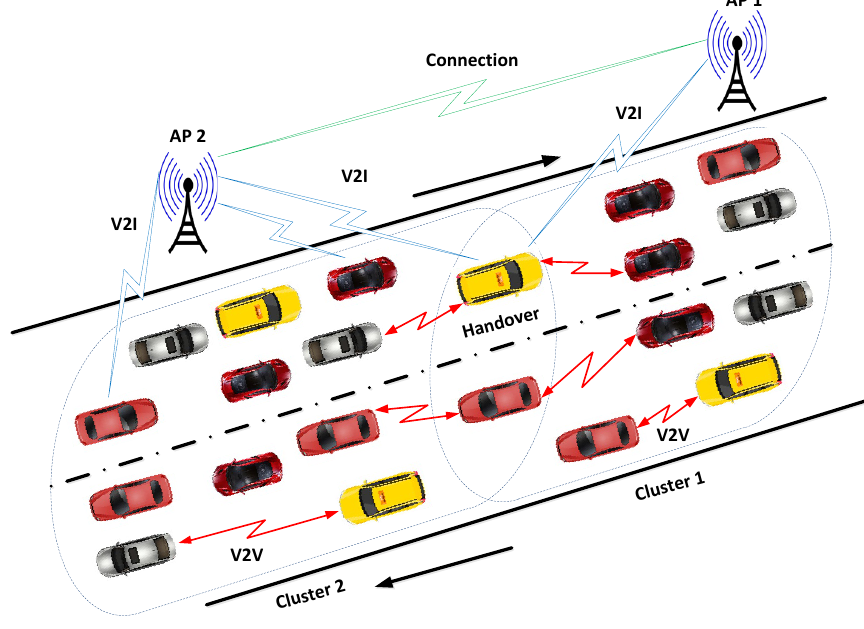
Figure 1. Handover in